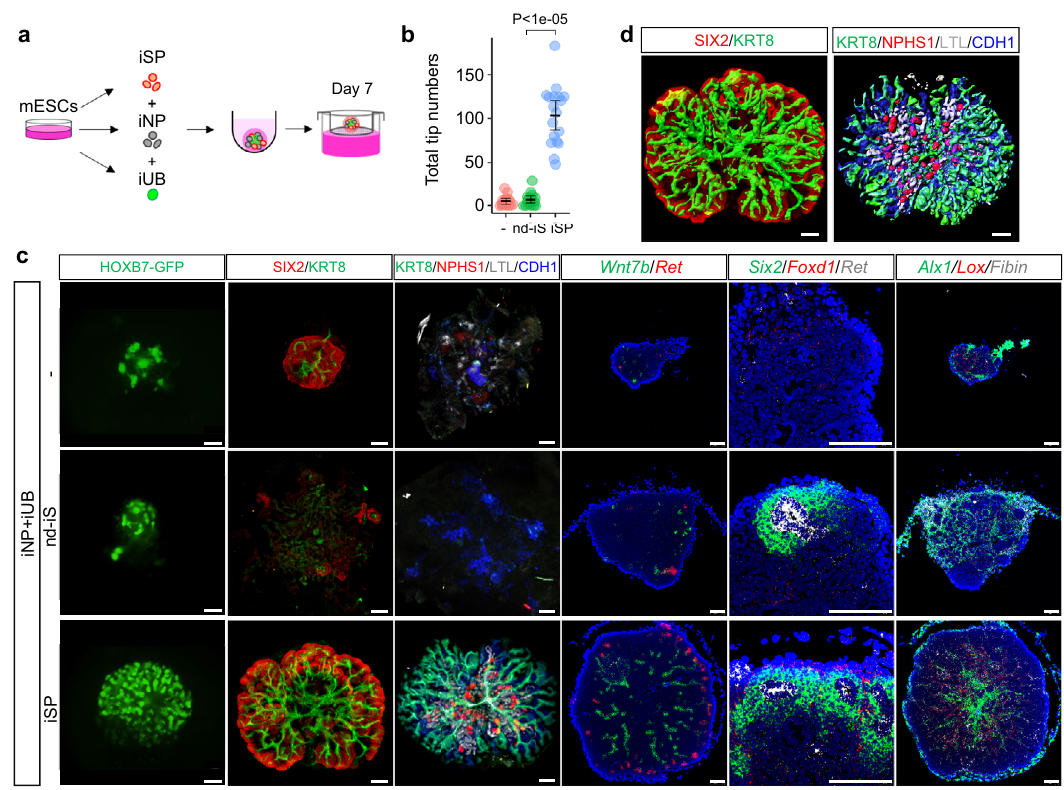
Fig. 4 Kidney organoids solely derived from ESCs exhibit the organotypic “ higher-order structure ” in vitro. a Schematic diagram of kidney organoid formation. iSPs, iNPs, and iUBs derived from Hoxb7-GFP mouse ESCs are combined, and cultured at the air/liquid interface for 7 days. b UB branch numbers in kidney organoids. Data are shown as mean ± SEM ( n = 16, 15, and 18 biologically independent samples, respectively). The Tukey – Kramer (two-sided) test was performed. The source data are provided as a Source Data fi le. c Mouse ESC-derived organoids formed without stromal cells ( − ), with nd-iS, or with iSPs. 1st column: GFP images of UBs; 2nd column: whole-mount immunostaining of SIX2 (NPs) and KRT8 (UBs); 3rd column: whole-mount immunostaining of KRT8 (UBs), NPHS1 (glomerular podocytes), LTL (proximal tubules), and CDH1 (UBs, distal tubules); 4th column: in situ hybridization of Wnt7 (UB stalks) and Ret (UB tips); 5th column: in situ hybridization of Six2 (NPs), Foxd1 (SPs), and Ret (UB tips); 6th column: in situ hybridization of Alx1 (medullary stroma), Lox (cortical stroma), and Fibin (outer layer of cortical stroma). Scale bars: 100 μ m. Six organoids in each condition obtained from three independent experiments were analyzed. d Digitized images of the whole-mount staining data in the 2nd and 3rd columns of ( c ). Scale bars: 100 μ m. Four organoids obtained from two independent experiments were